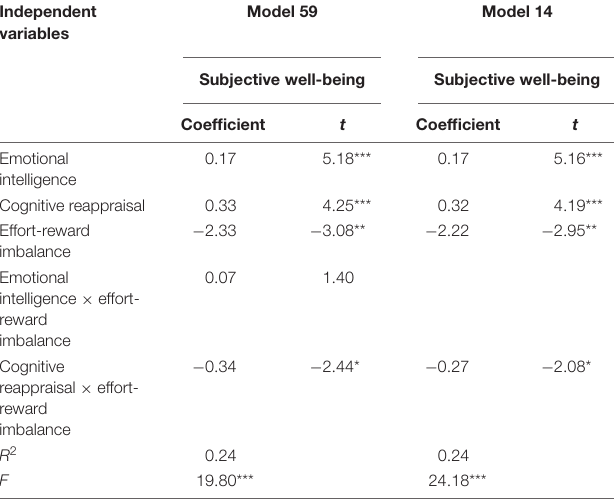
TABLE 5 | Results of the moderated mediation